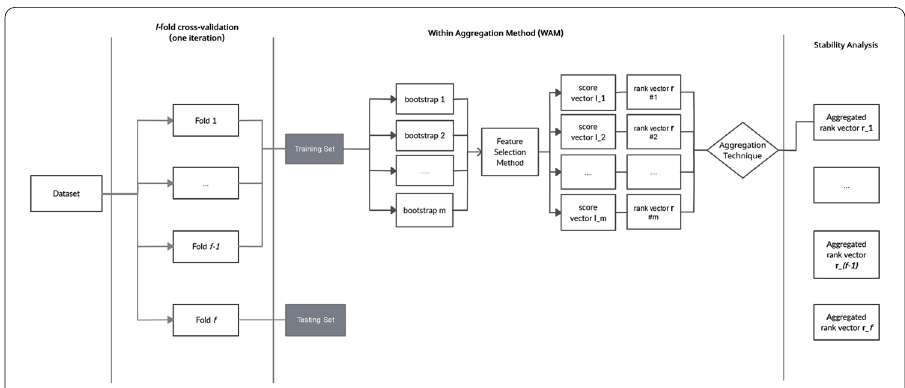
Fig. 2 Framework for Stability